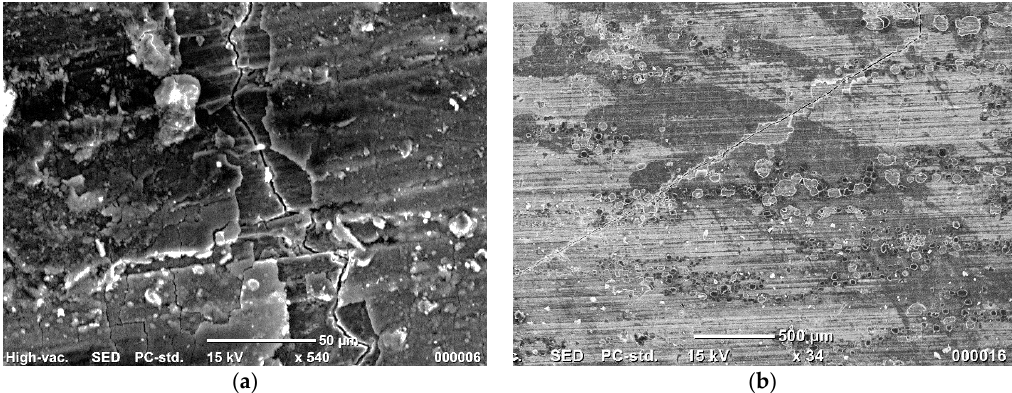
Figure 10. ( a ) Crack initiation in a pre-corrosion pit; ( b ) crack propagation following intergranular path.